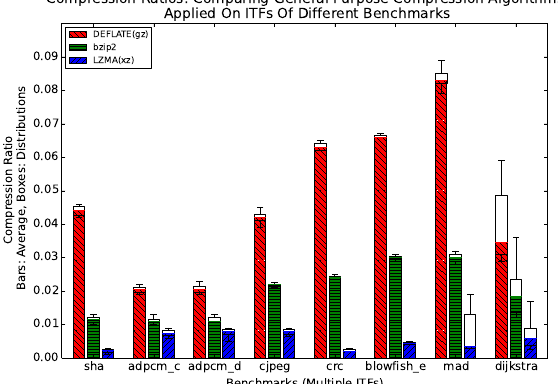
Figure 3: The compression ratio of general puprose com- pression methods. Multiple ITFs of different benchmarks were used as an